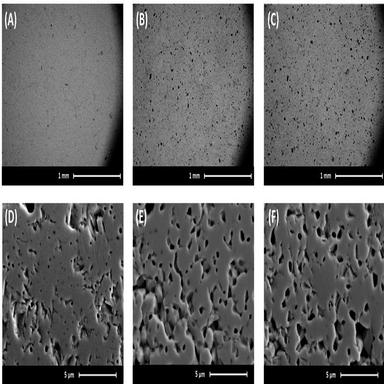
50x compositional backscatter and 4000x secondary electron images of undoped UO2 (A and D), 25 GWd/tU SIMFuel (B and E) and 43 GWd/tU SIMFuel (C and F) after polishing with decreasing SiC paper and diamond paste grades.